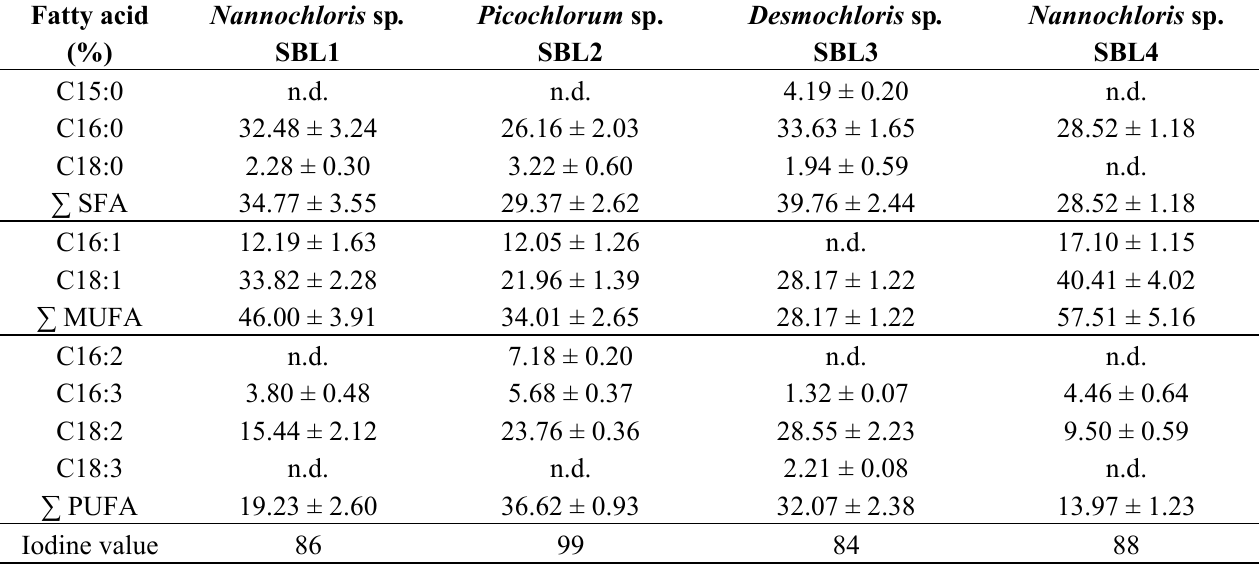
Table 2. Fatty acid profile and iodine value of the strains studied throughout this